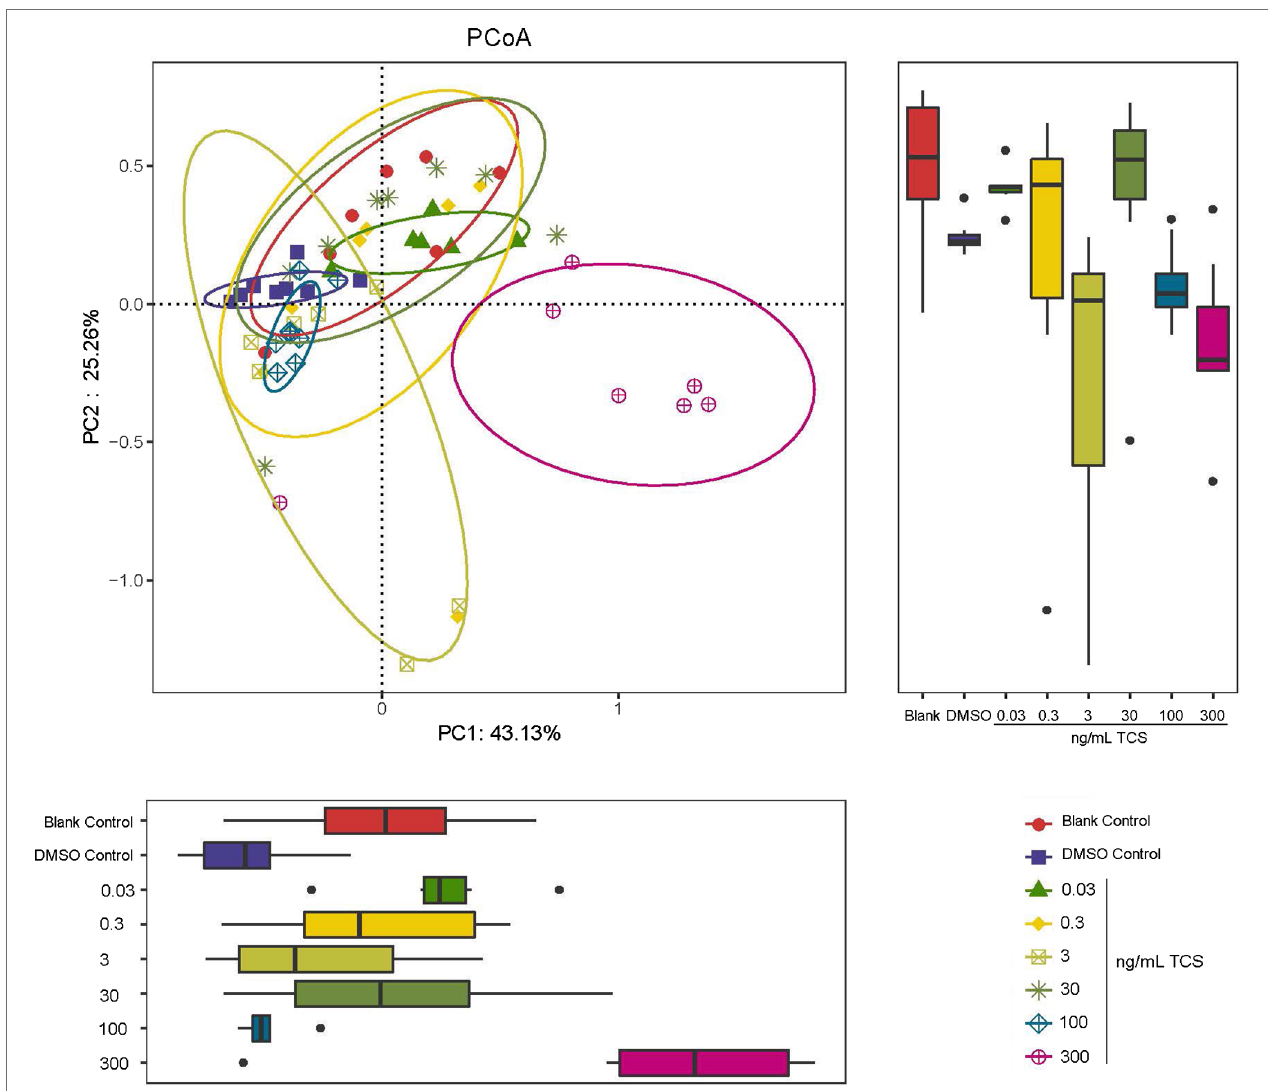
FIGURE 2 | PCoA analysis of beta-diversity of microbiota in the gastrointestinal tract in zebrafish with different concentrations of TCS exposure. The bacterial communities of microbiota in the gastrointestinal tract in zebrafish clustered by TCS treatment on the PCoA diagram. TCS exposure at 300 ng/ml level was associated with separation on PC1 and